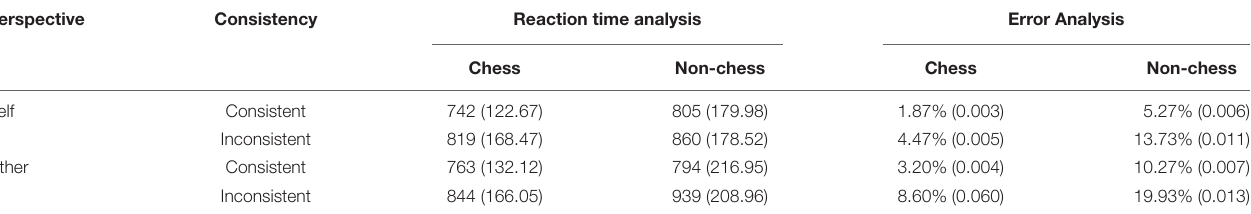
TABLE 2 | Experiment 1 descriptive